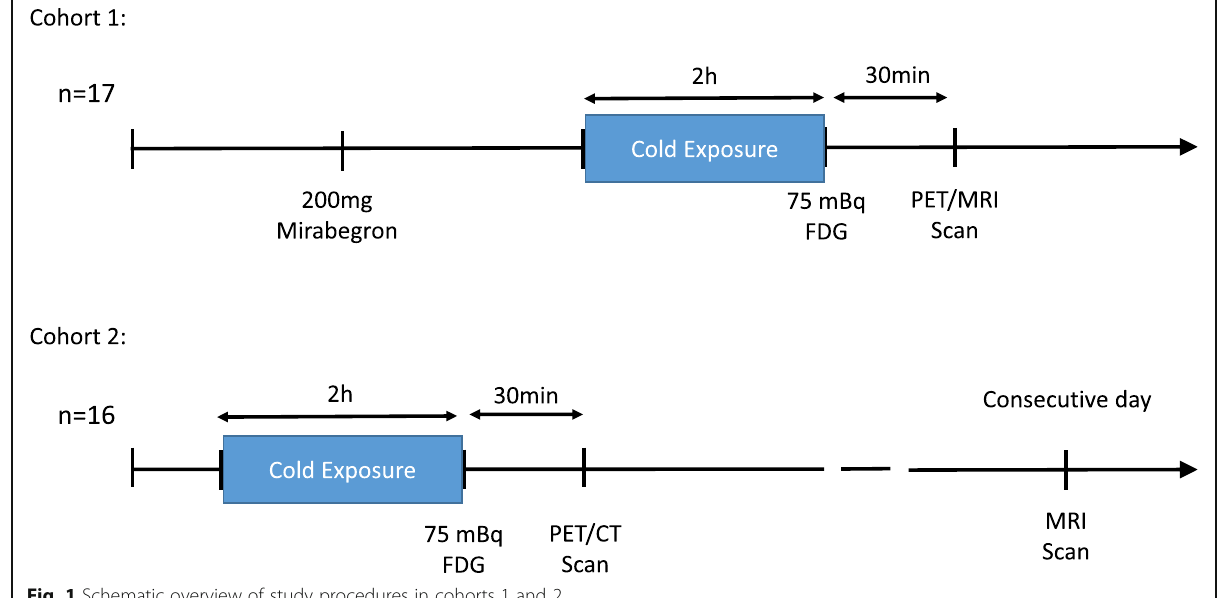
Fig. 1 Schematic overview of study procedures in cohorts 1 and 2